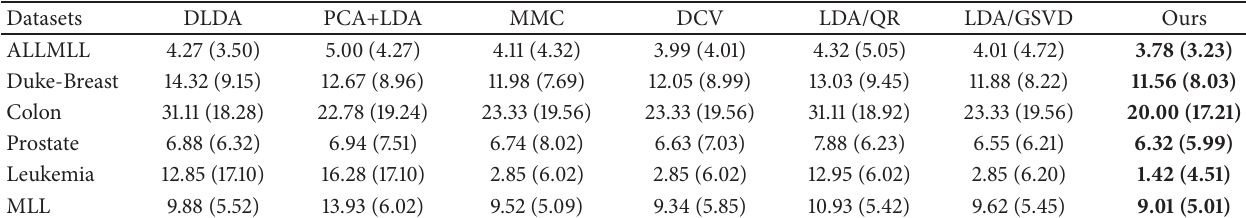
Table 4: Error rates (%) of each method on microarray data